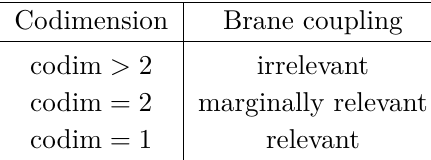
Table 1 . Relation between the brane codimension and the behaviour of its couplings along the RG